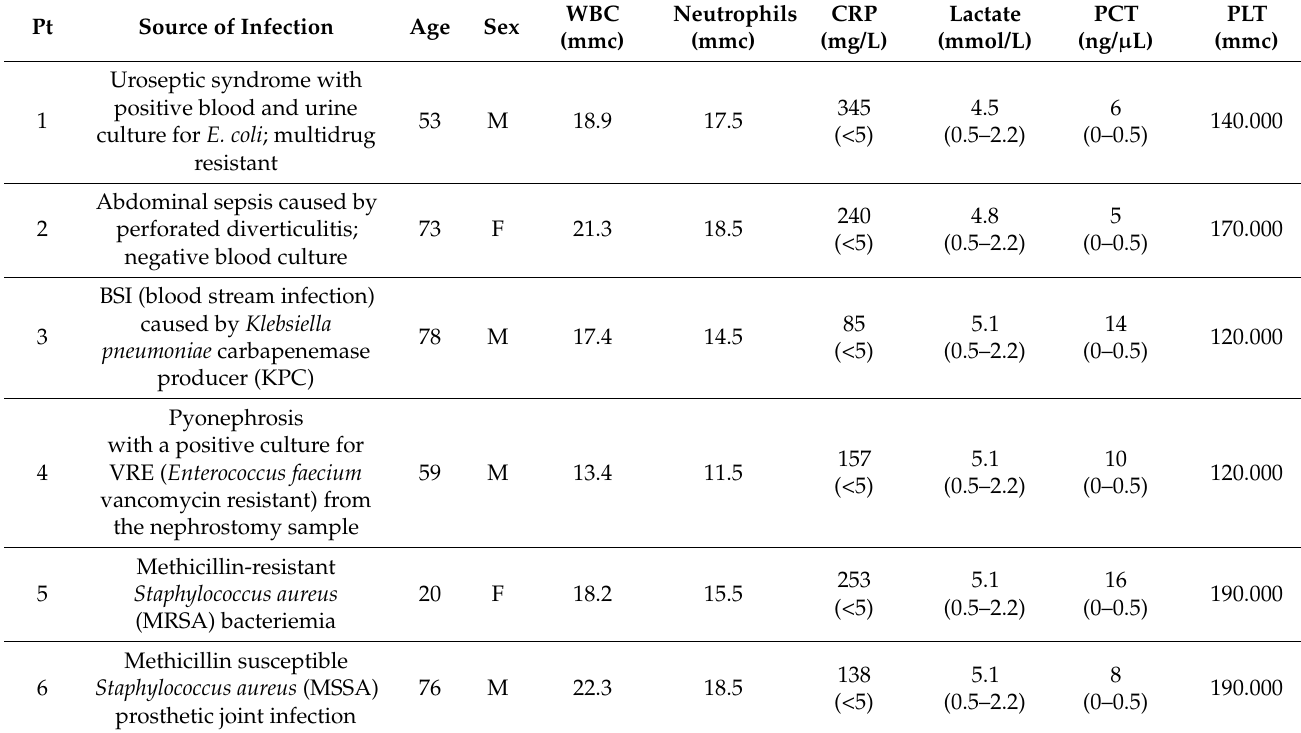
Table 1. Characteristics of sepsis patients, showing source of infection and causative pathogens, demographic data (age and sex), and routine blood results from admission of the six sepsis patients